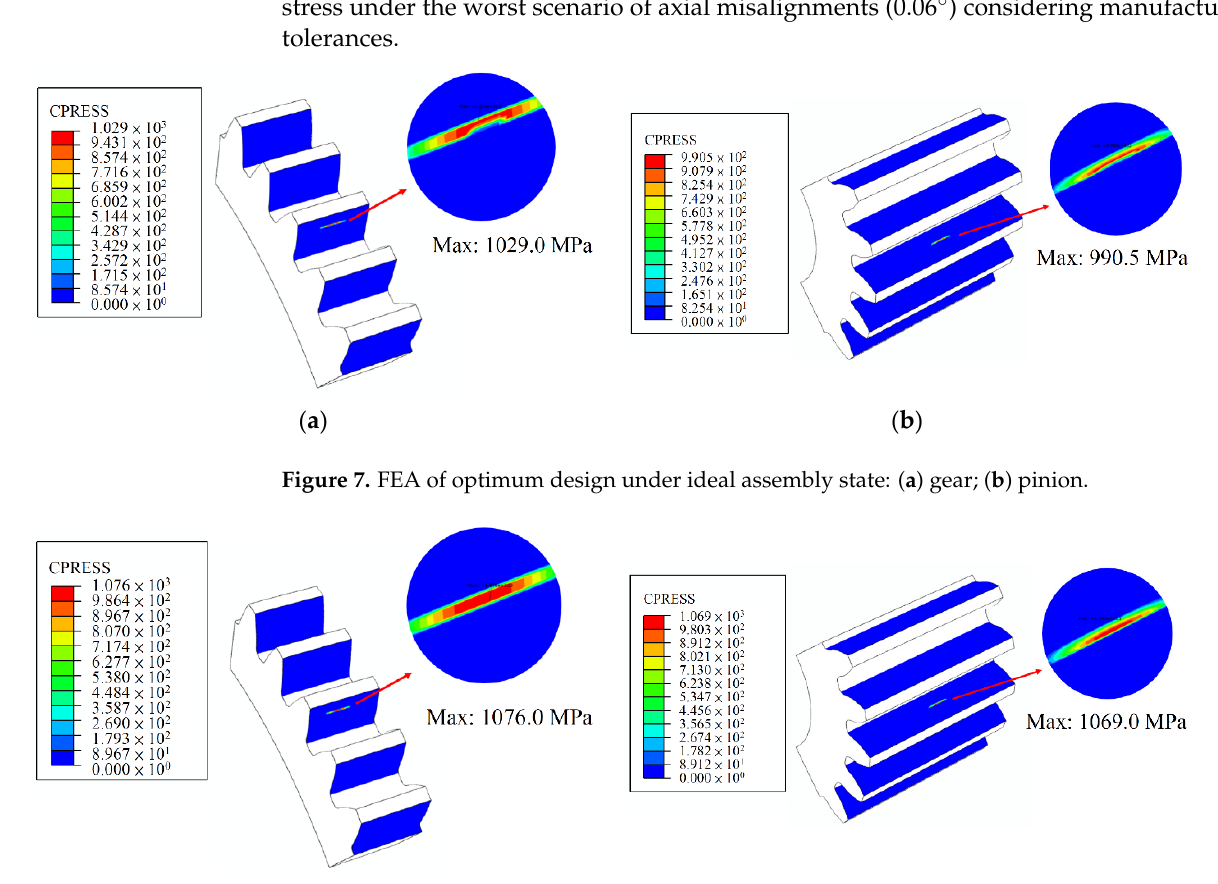
Figure 8. Contact stress of optimum design with horizontal axial misalignment of 0.06°: ( a ) gear; ( b ) pinion.